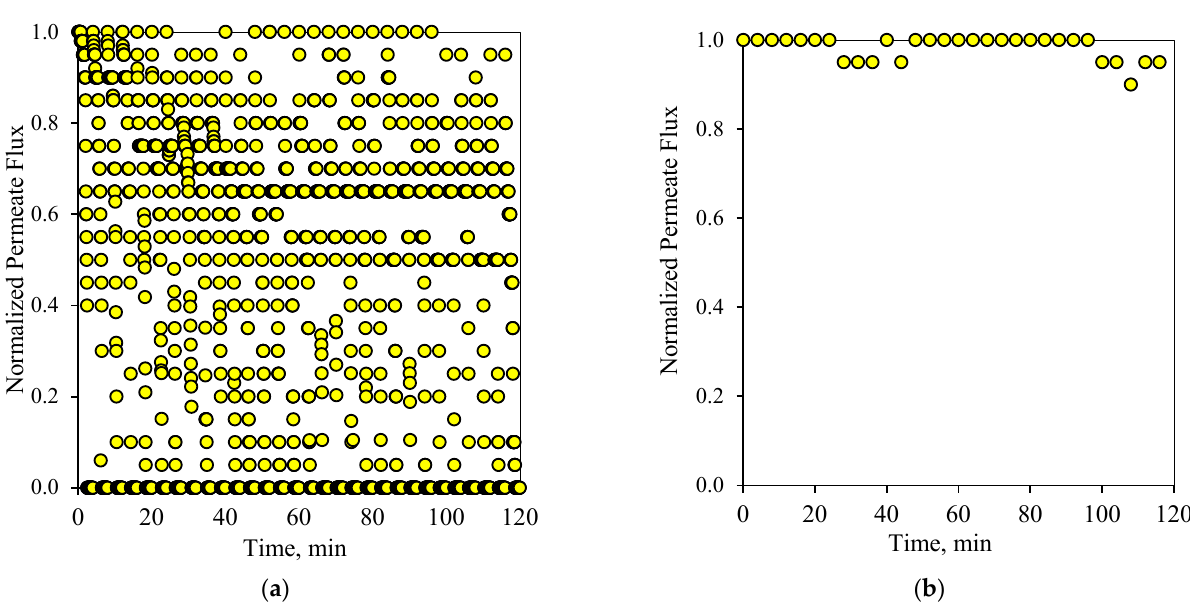
Figure 11. Permeate flux profile using the 2-2 PFPT for a feed of 200 ppm at CFV: 1 m/s: ( a ) 2 h of filtration operation, ( b ) membrane permeability after each cleaning half-cycle.